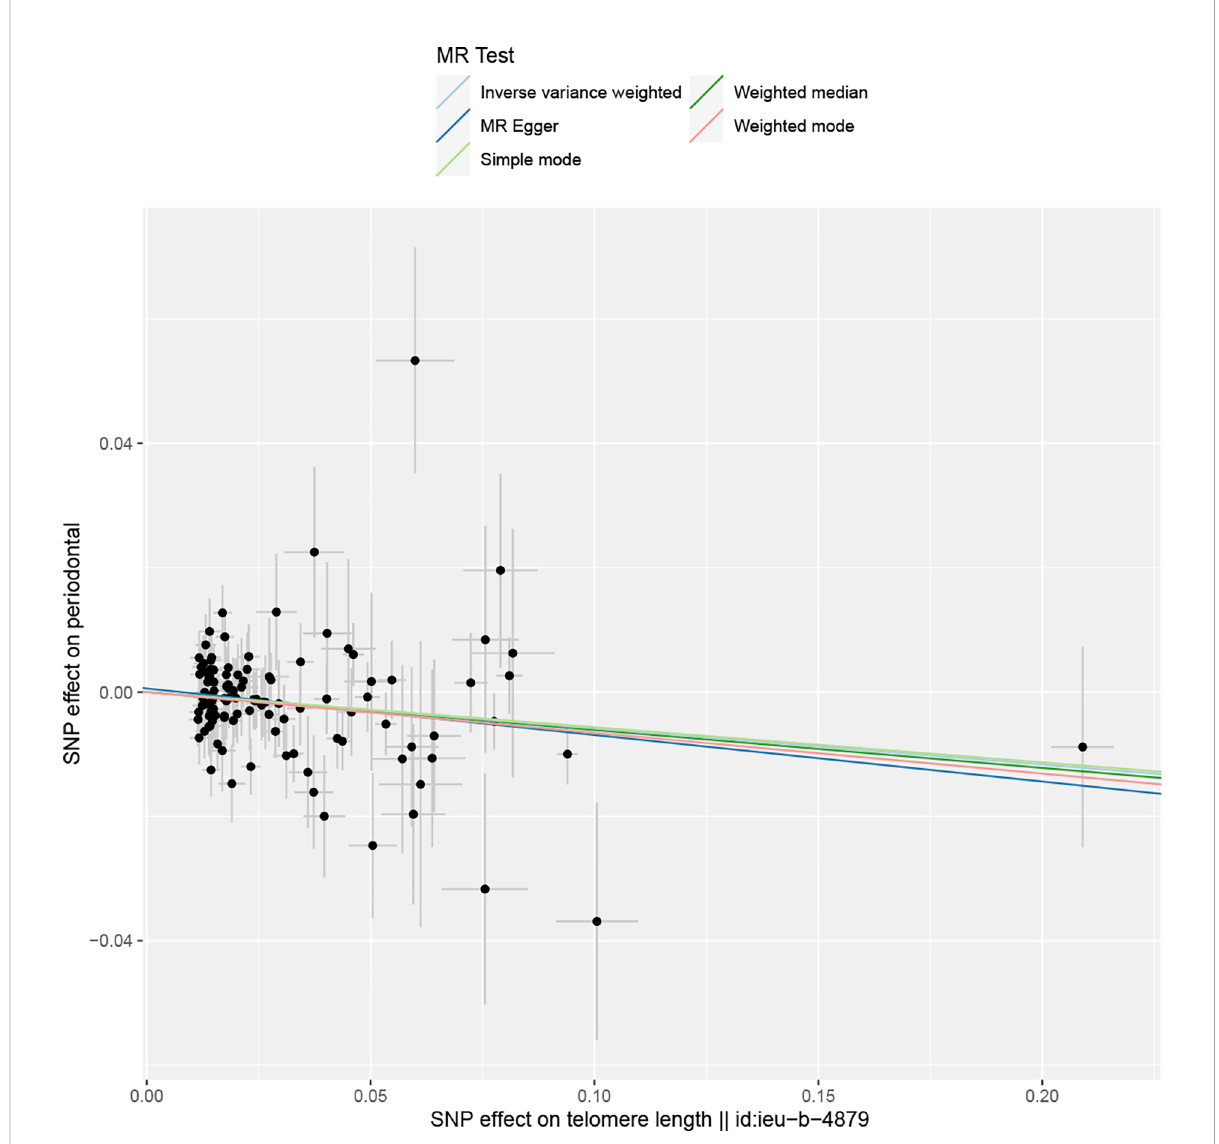
FIGURE 3 The reverse MR: Scatter plot of the effects of SNPs on TL and periodontitis. The horizontal and vertical axes represent the effect of each genetic variation on telomere length and periodontitis. The gray line around the black solid point indicates the corresponding 95% CI for the effect. The slopes of the solid lines show the effect estimates of the fi ve MR methods. MR, mendelian randomization; SNP, single nucleotide polymorphism; CI, con fi dence